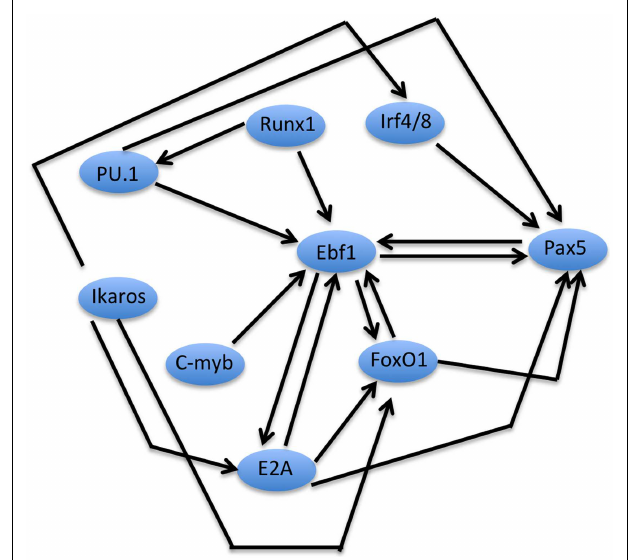
FIGURE 3 |An early B cell specification module. Schematized network of inter-dependentTFs regulating early B cell development.The scheme depictsTFs that have been implicated in the control of early B cell specification and/or commitment (for clarity, factors such as Spi-B, OBF1, or NF-KB, which are important at later stages of B cell development, are not depicted here). Direct positive regulation between two factors at the transcriptional level is indicated by the corresponding arrows. Note that the scheme does not imply biochemical interactions (e.g., complex formation) between the factors, although they may also take place in some